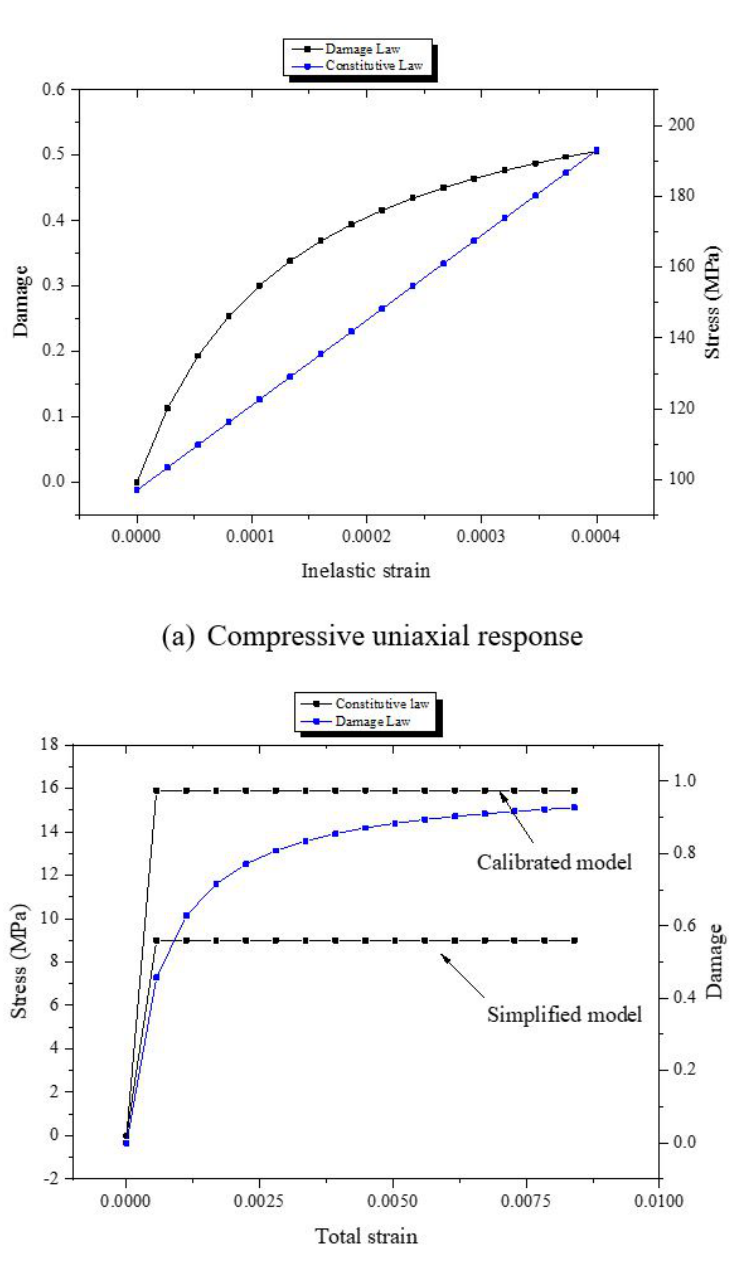
Figure 4. (a) e (b) UHPFRC Constitutive model - Graybeal